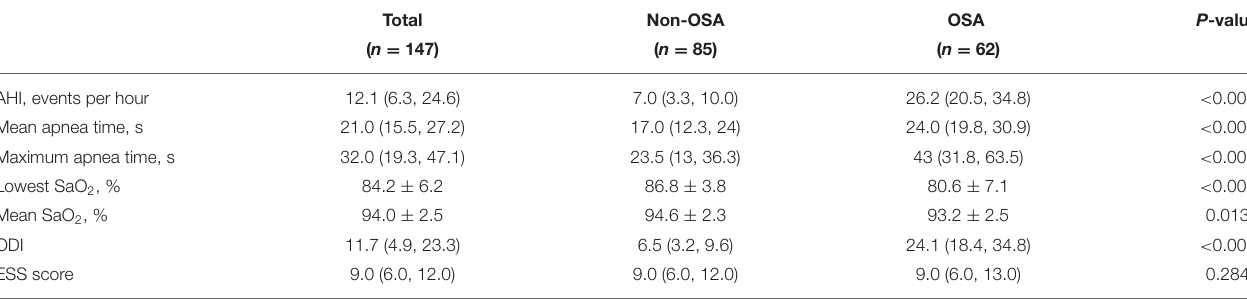
TABLE 2 | Sleep monitoring findings of patients.